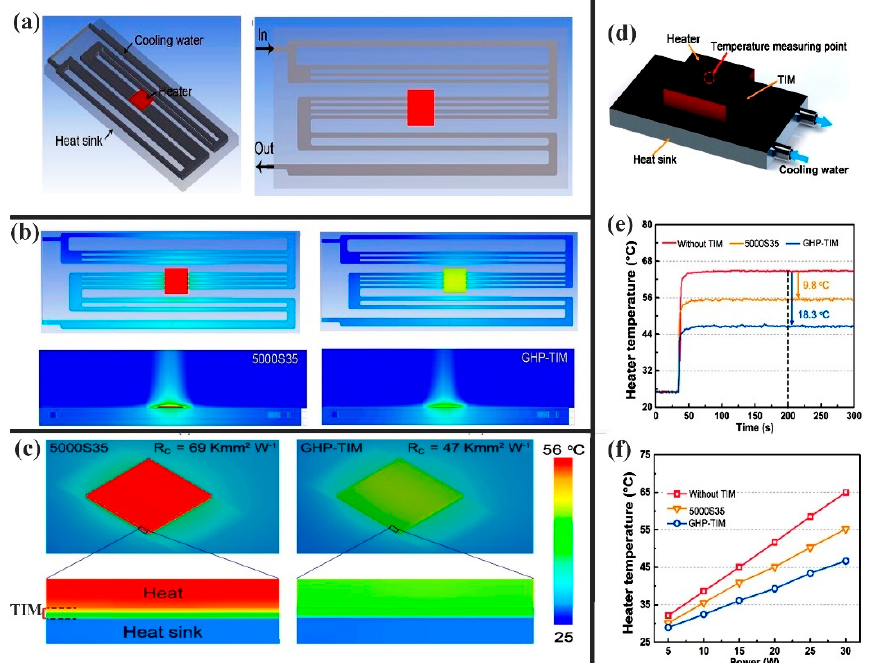
Figure 29. ( a ) Icepak system model of the graphene hybrid paper (GHP). ( b ) Temperature distribution of the simulated system with Bergquist 5000S35 or the GHP as thermal interface materials (TIMs). ( c ) The heat dissipation based on simulated profiles. ( d ) Schematic configuration of GHP performance evaluation system. ( e , f ) Temperature evolution of ceramic heater as a function of heating time at the heater power of 30 W and various applied powers after heating for 200 s (reproduced with permission from [201]).